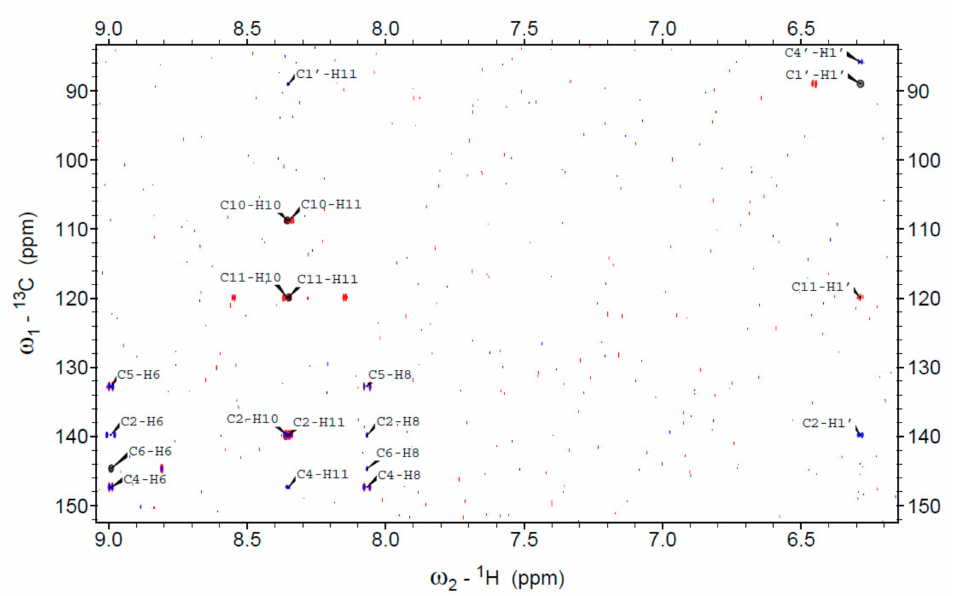
Figure 9. Aromatic and H(1 (cid:48) ) / C(1 (cid:48) ) ribose region of the contour plots of 1 H, 13 C correlation spectra of N 2 ,3-etheno-2-aminopurine riboside ( 5 ) in DMSO-d 6 (at 1 H frequency of 500 MHz, at 25 ◦ C) showing the cross-peaks between the ribose and nucleobase nuclei. Contours are plotted: for HSQC (black), for 8 Hz optimized HSQMBC (red), and for 2 Hz optimized HSQMBC (blue). All peaks are marked at the center of the multiplet and labeled according to the assigned nuclei (Table 2).